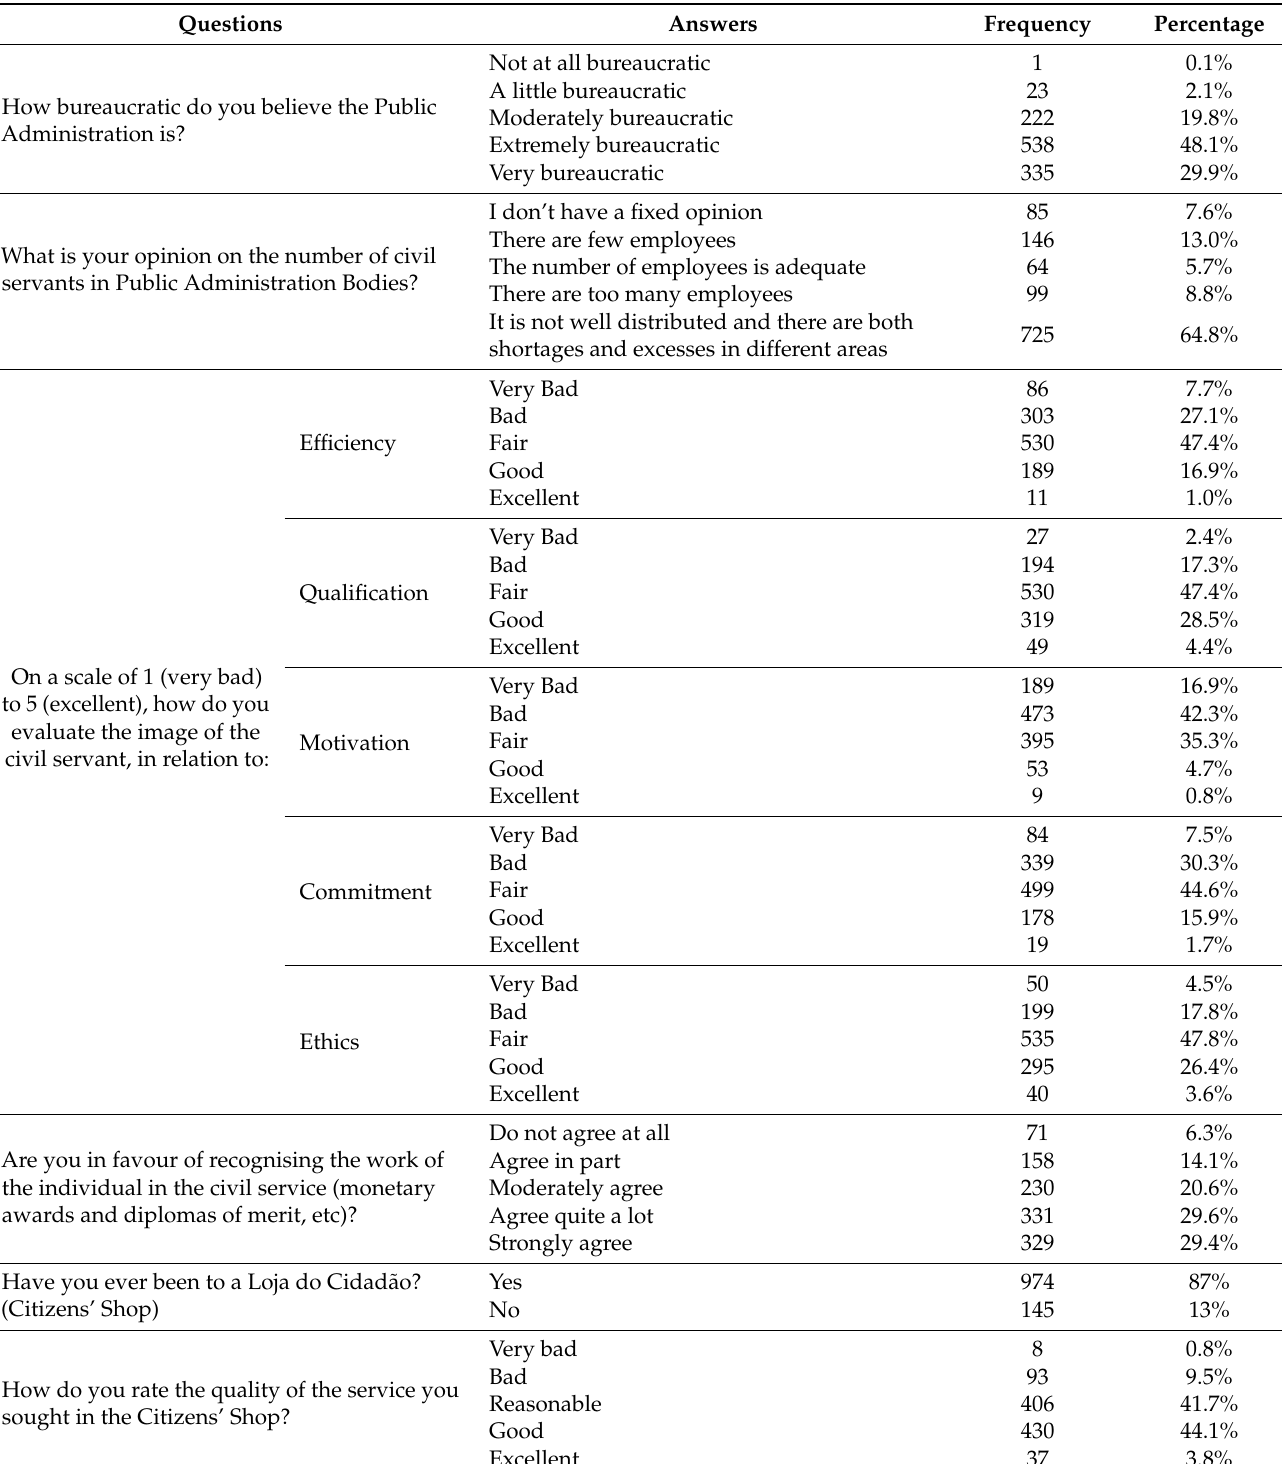
Table 3. Descriptive statistics of the survey questions on Portuguese